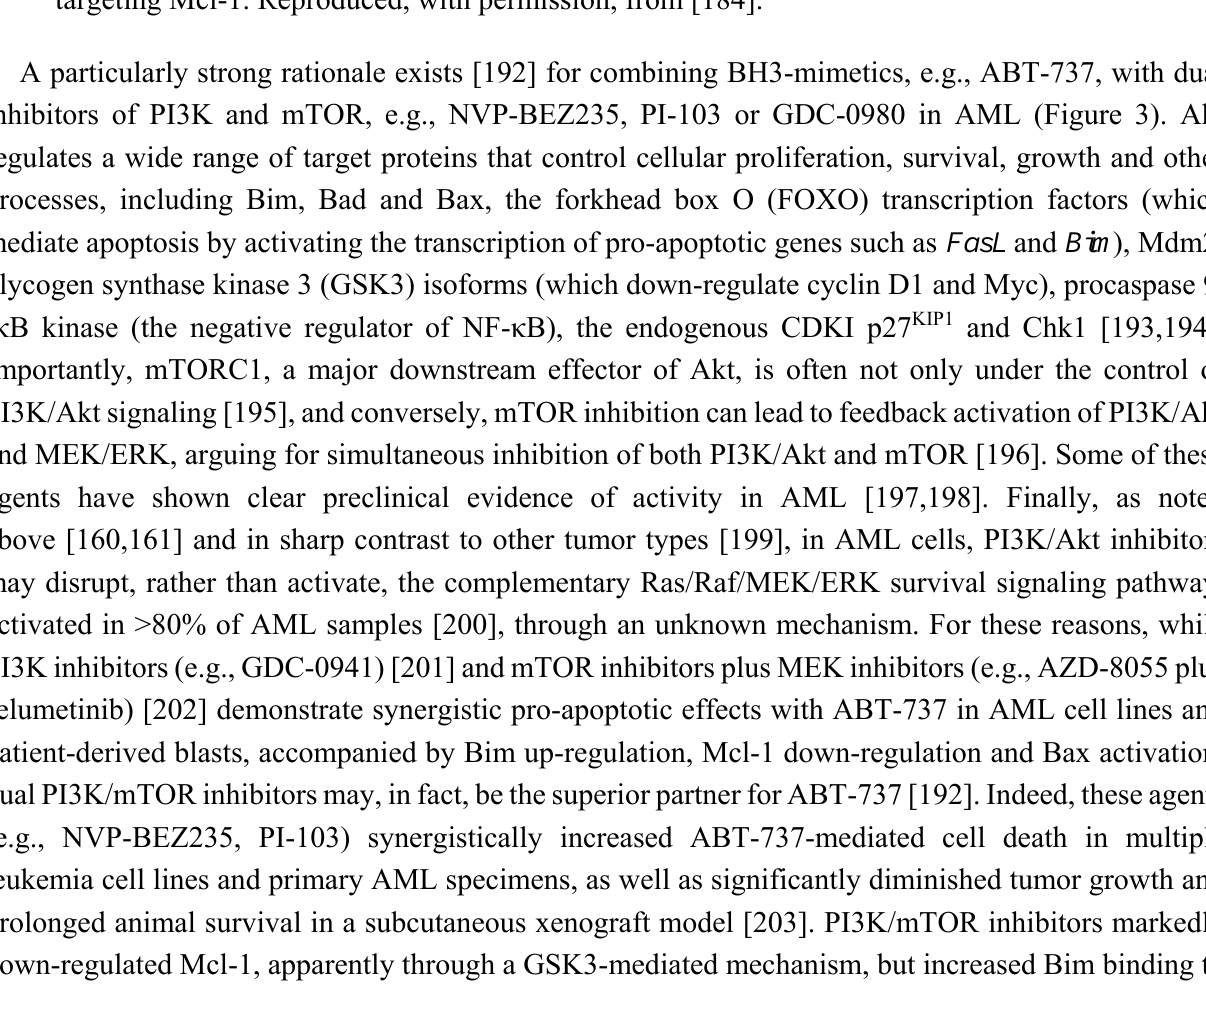
Figure 2. Should be: Mechanisms of potentiation of BH3-mimetic lethality by strategies targeting Mcl-1. Reproduced, with permission, from